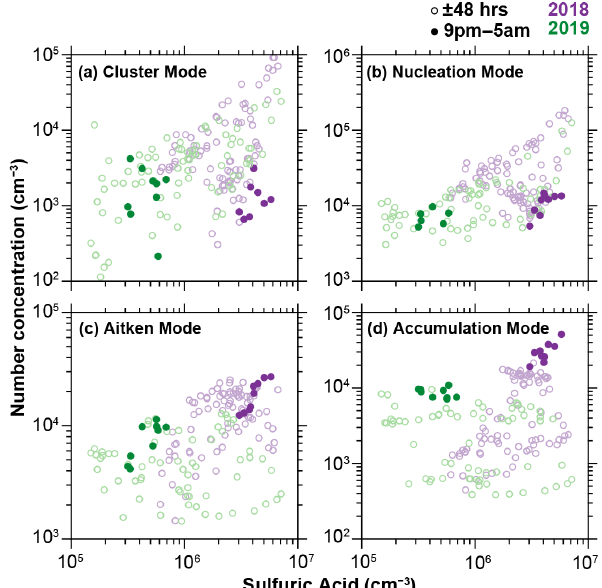
Figure 7. Aerosol particle number concentrations in cluster, nucle- ation, Aitken, and accumulation modes as a function of gas-phase sulfuric acid concentration in 2018 (purple) and 2019 (green), sepa- rated from 21:00 through 05:00 the night of the CNY (filled circles), and those of CNY ± 48h (open circles). The data are from BUCT-